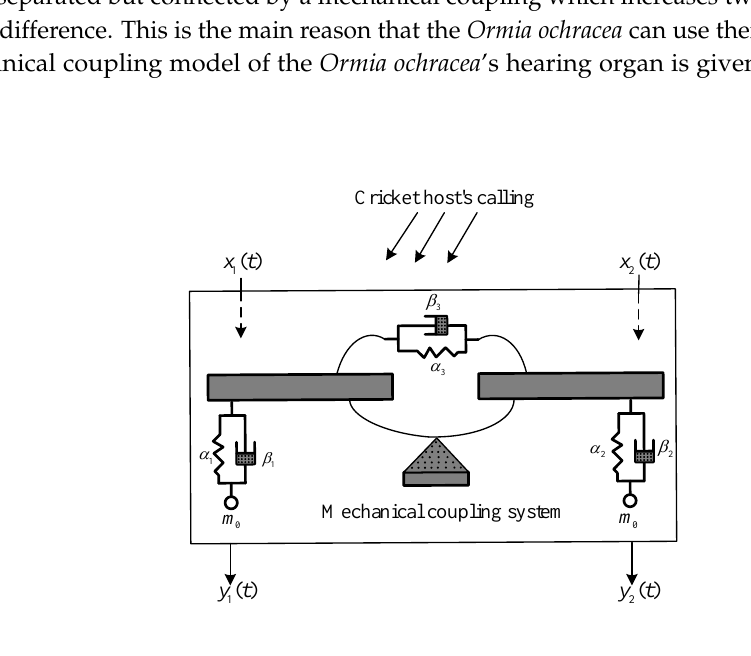
Figure 2. Mechanical model of the Ormia ochracea ’s two ears